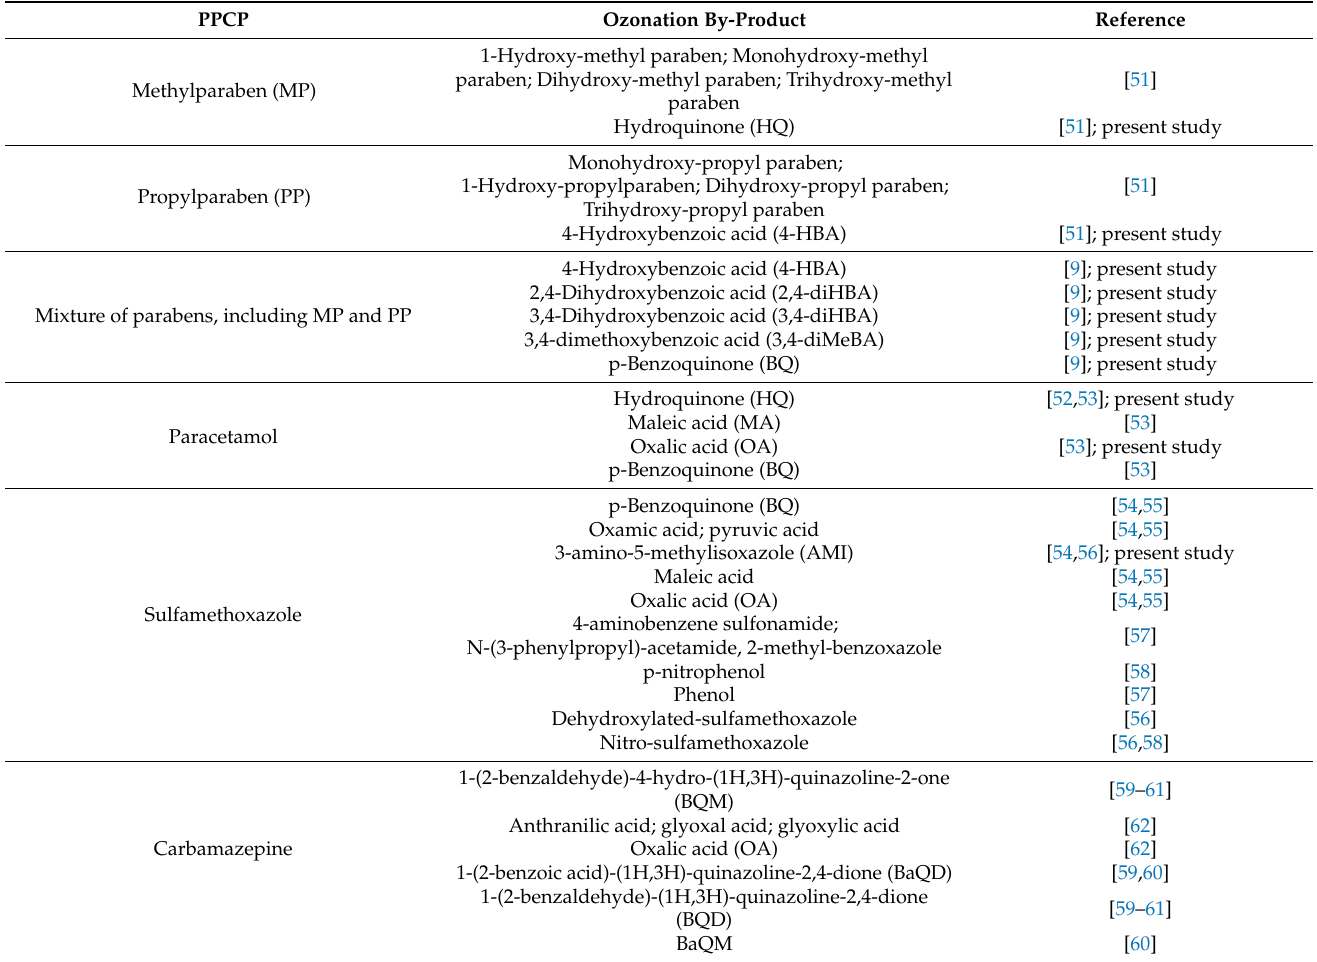
Table 3. Summary of the degradation by-products reported after the single ozonation of each of the tested